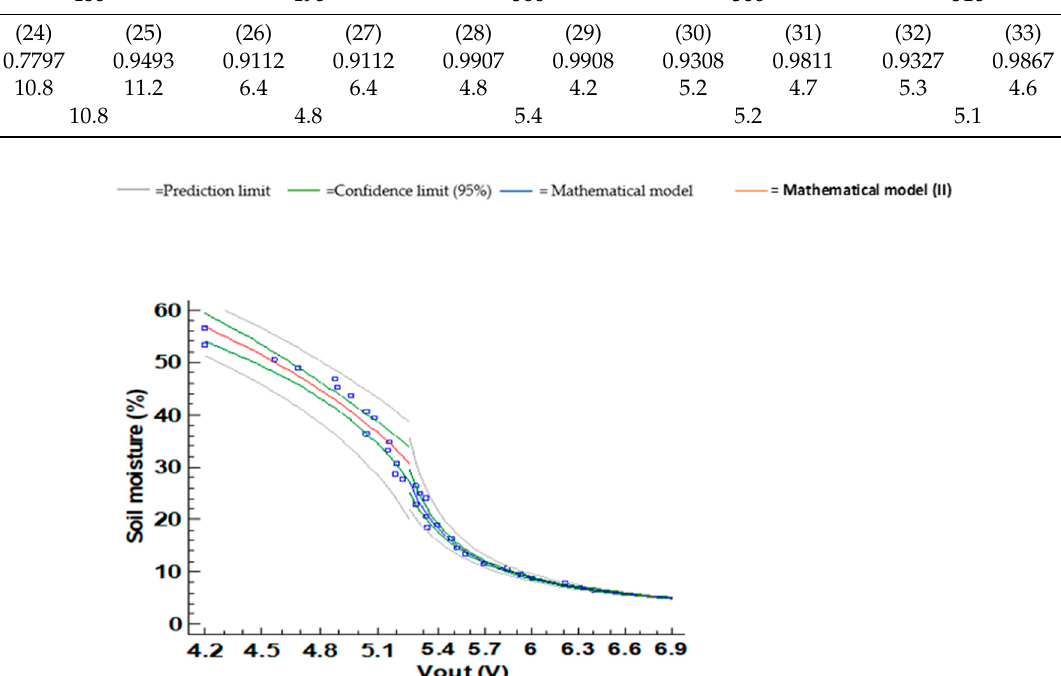
Figure 26. Vout NP2, 490 kHz, two models (II), Equations (26) and (27) as mathematical model I and II, respectively.